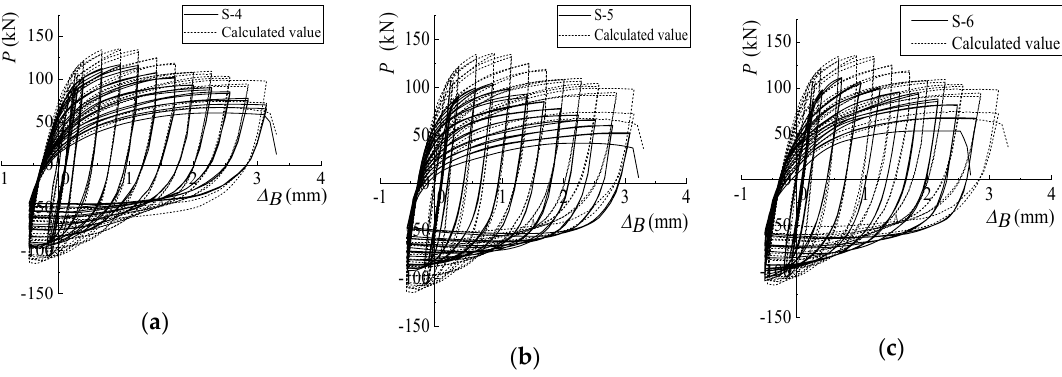
Figure 17. Hysteresis curve comparison: ( a ) S-4; ( b ) S-5; ( c ) S-6.